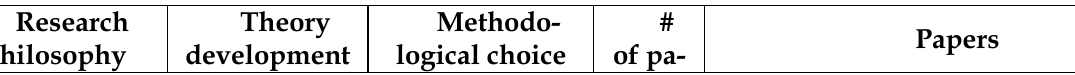
Table 7: Research philosophy and theory development approach